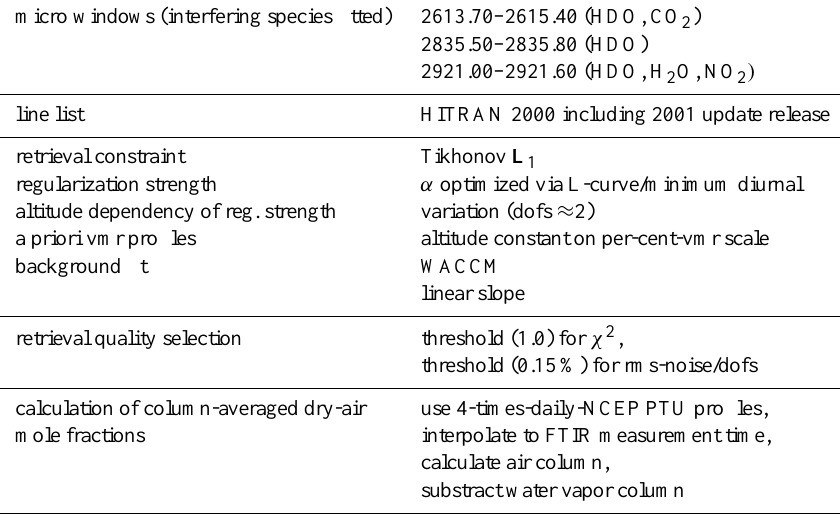
Table 8. Optimum strategy for retrieval of methane from mid-infrared solar spectra designated as MIR-GBM v1.0.